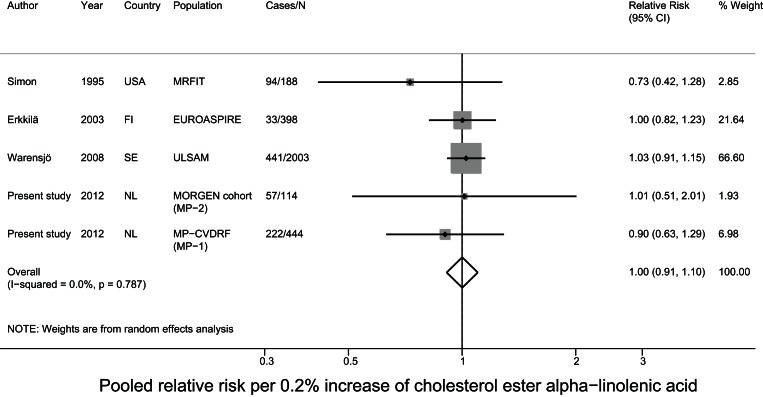
Pooled relative risk of cholesterol ester alpha-linolenic acid and CHD risk.